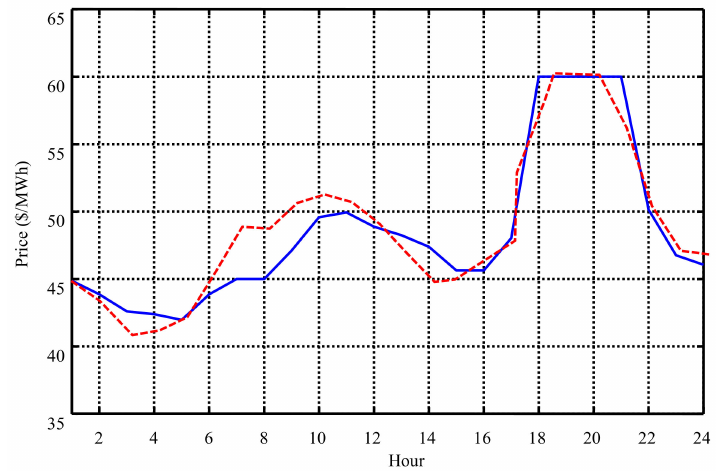
Figure 16. Daily forecast for the NYISO; continuous blue and dotted red